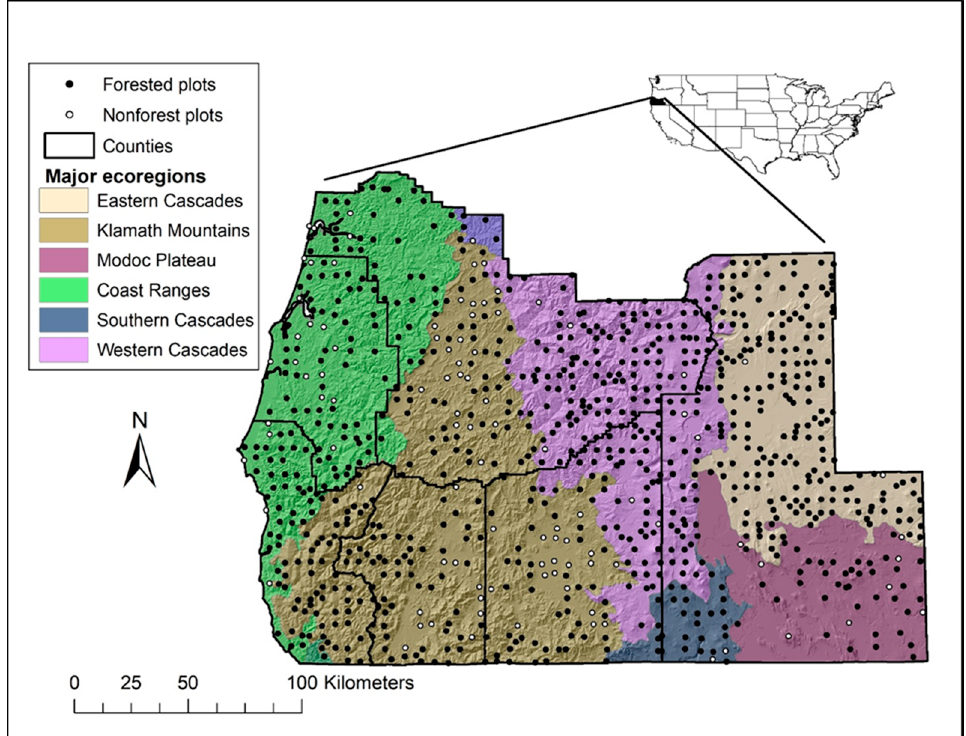
Figure 2. Map of the study area in southwest Oregon, showing approximate locations of remeasured plots used in the analysis, county boundaries, and the primary ecoregion sections (Cleland et al. 2007) over a topographic hillshade from a United States Geological Survey Digital Elevation Model.